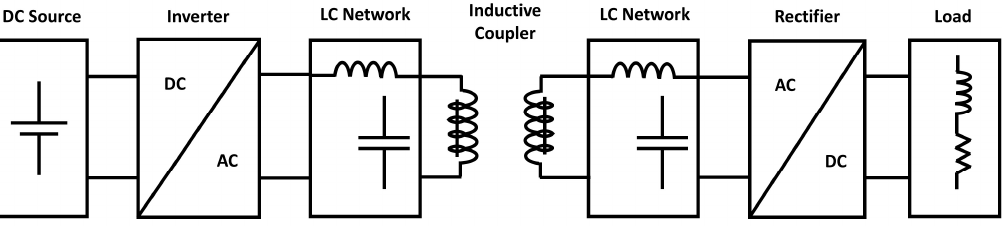
Figure 12. Architectural diagram of an inductive WPT system [16].